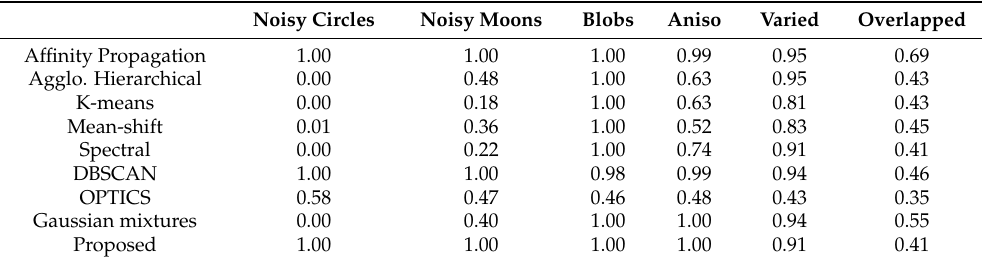
Table 4. The homogeneity of affinity propagation, agglomerative hierarchical, k-means, mean-shift, spectral, DBSCAN, OPTICS, Gaussian mixtures, and the proposed clustering methods on noisy circles, noisy moons, blobs, anisotropic, varying variance, and overlapping datasets. Noisy Circles Noisy Moons Blobs Aniso Varied